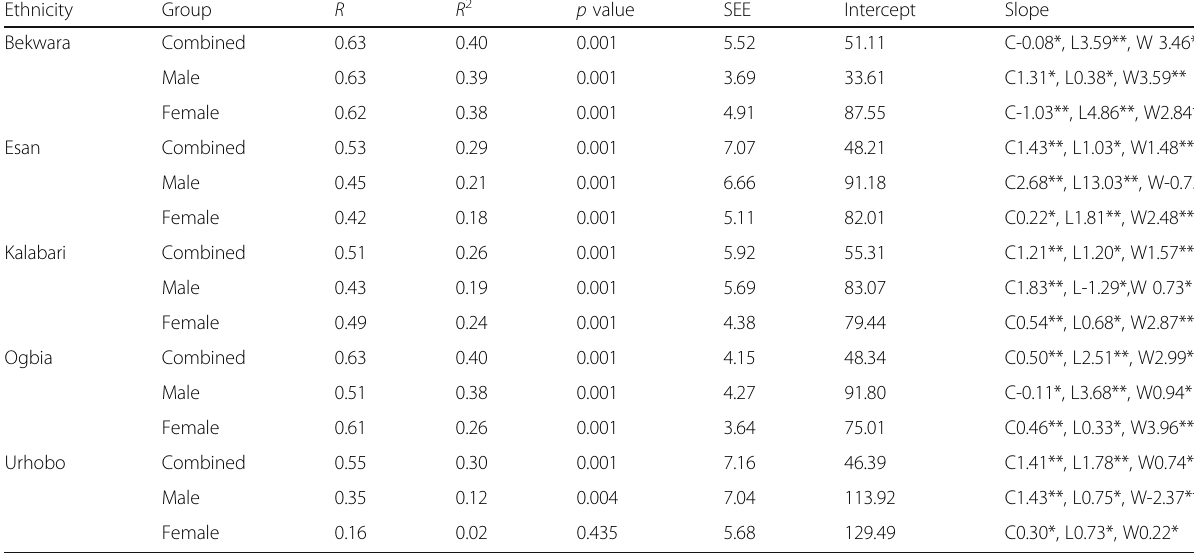
Table 8 Result of multiple regression of height on head dimensions